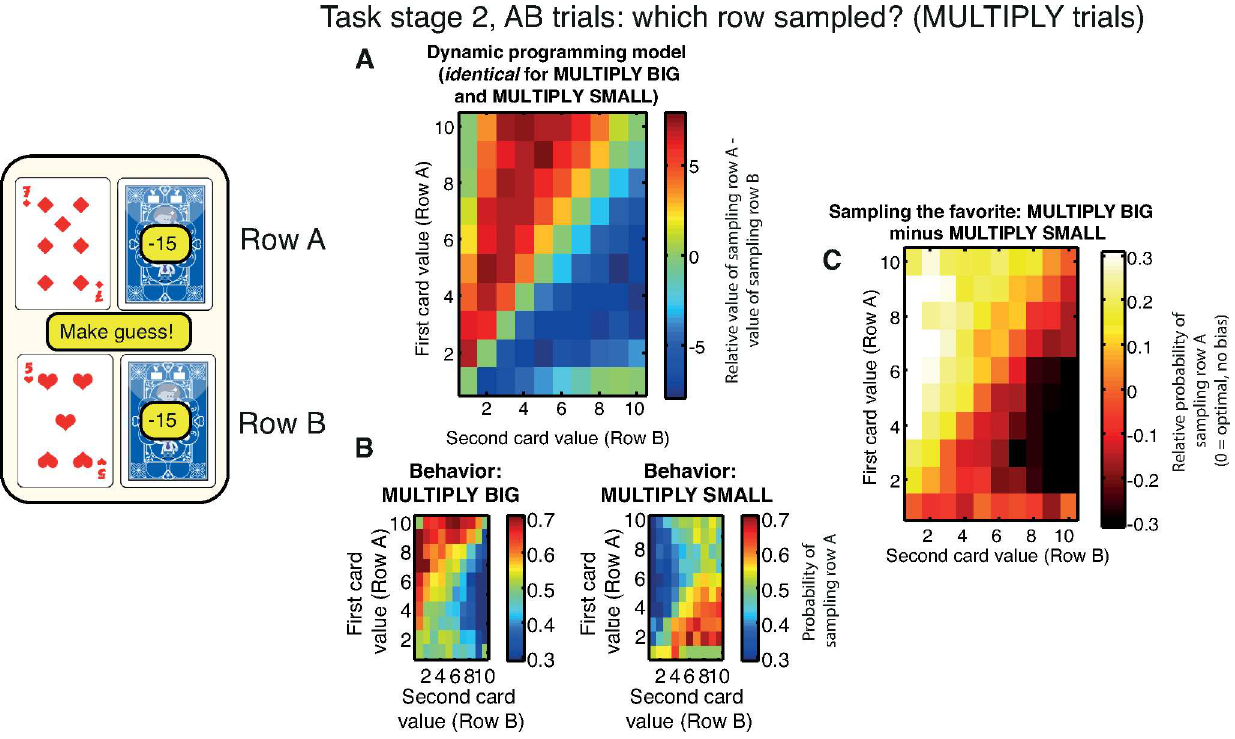
Fig 4. Sampling the favorite bias at Task Stage 2. If subjects choose to sample at Task Stage 1, they enter Task Stage 2. If this is on an AB trial, they then may sample again from row A, or from row B, or make a guess. (A) Model predictions. The relative expected value (in points) of samplingfrom row A versus samplingfrom row B in the MULTIPLY conditions. It is generallymore valuable to sample from the row that currently has the higher-valued card (e.g., the 7, in the example shown). Crucially, this predictionis the same in both MULTIPLY BIG and MULTIPLY SMALL conditions. (B) Subject behavior. Subjects show a propensity to sample from the row containingthe high-valuedcard in MULTIPLY BIG, but this trend is reversed in MULTIPLY SMALL. Subjects are therefore inclined to sample the option that is currently most likely to be approached. (C) Samplingthe favorite bias is revealedby subtracting MULTIPLY SMALL trials from MULTIPLY BIG trials. The normative model predicts this heat map to show no differencebetween conditions, yet there is a clear tendency to sample the currently favored row. See also S6 Fig and S7 Fig for other conditions, and S8 Fig for relative value of guessingversus samplingacross all six conditions. Data for reproducing all analysesis freely availablefor downloadfrom